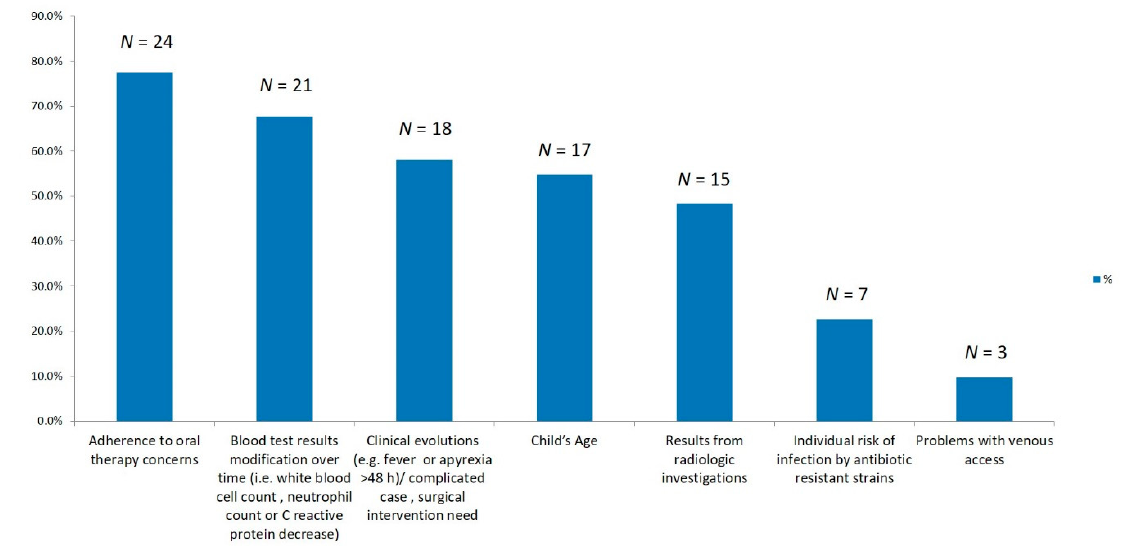
Figure 2. Factors influencing the switch from intravenous therapy to oral therapy in 31 Italian pediatric clinics.